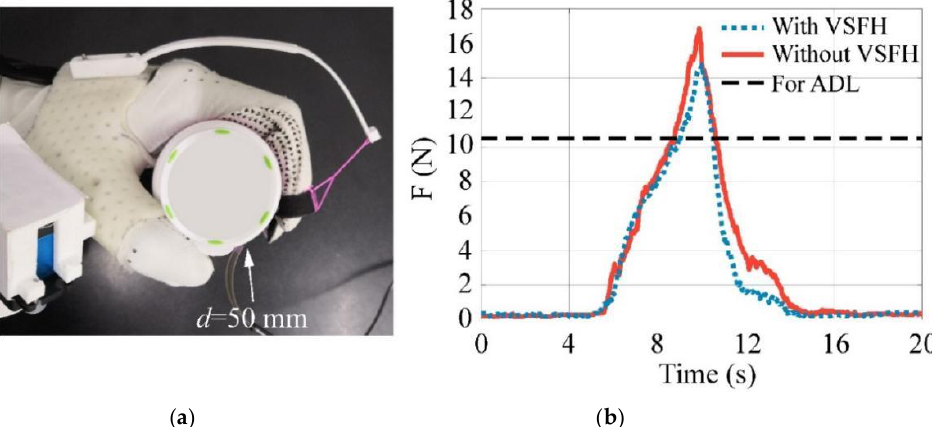
Figure 13. Measurement ( a ) and results ( b ) of the index fingertip force when grasping a cylinder with a diameter of 50